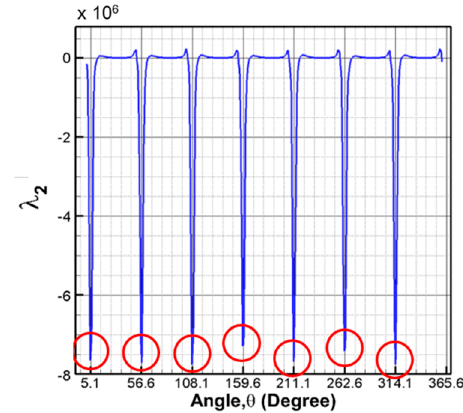
Figure 10. A variation of λ 2 along the circular line in Figure 9b .